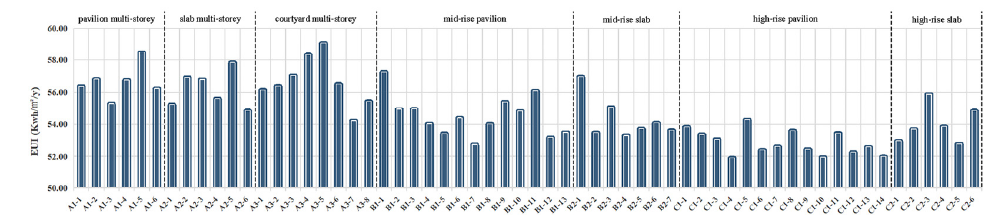
Figure 12. Distribution characteristics of total EUI of sixty office block samples.